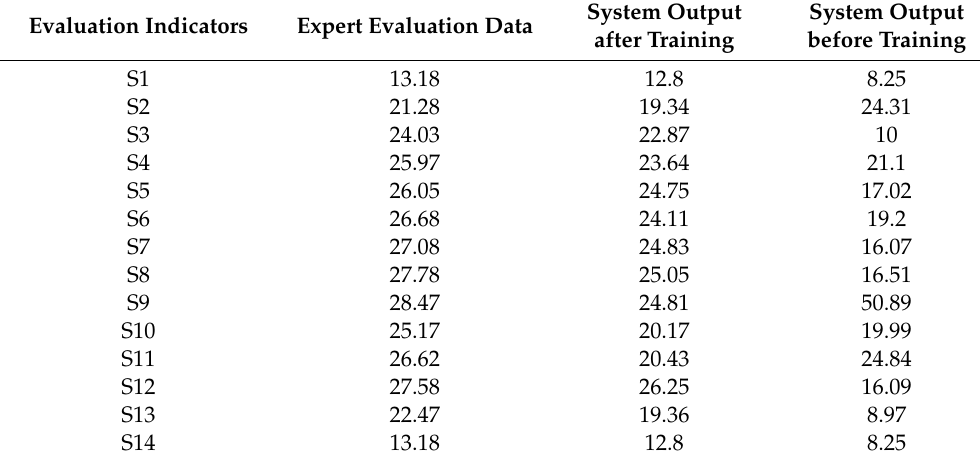
Table 6. Comparison of original evaluation results: system output before training and system output after training.